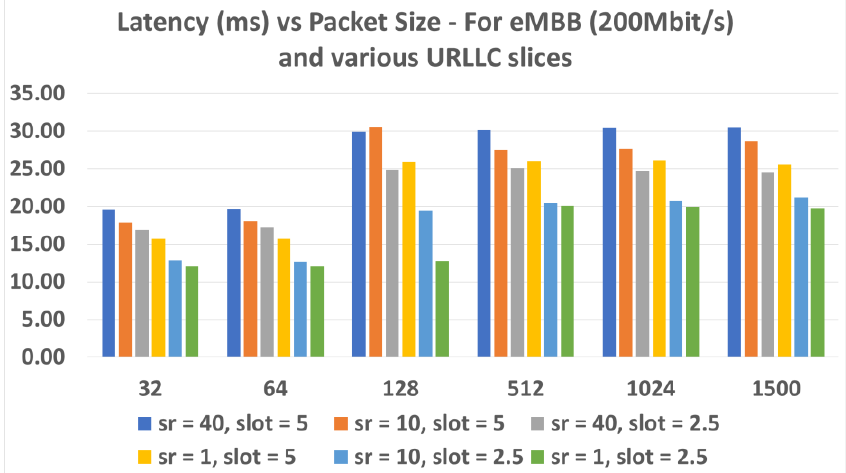
Figure 6. Latency results for a 200 (Mbits/s) eMBB slice and 6 different URLCC slices. It is evident from both set of results that the case of the URLLC slice of srPeriod = 1 and slot Period = 2.5 display the best performance in terms of latency for a URLCC slice, with an average minimum latency of ~12 ms. These values indicated the best achievable latency performance measured in the proposed 5G platform for end-to-end measure- ments. The last set of experiments was performed over the different combinatory EMBB and URLLC slices, in order to comprehensively investigate the effect of different packet sizes on different data paths and analyze their energy impact. As can be deduced, the main factor contributing to higher energy consumption is diminutive packet size, which is ex- pected, as this contrivance performs significantly more transmissions to obtain the same level of bitrate, to procure the slice bitrate requisite. Furthermore, the most consequential conclusion of these experiments is that a lower latency requires more energy, as can be clearly seen from Figure 7. The configuration for minimum latency (sr = 1, slot = 2.5) con- sumes more energy in all different packet-size cases. Consequently, the trade-off between energy consumption and latency subsists in the 5G domain. Moreover, it should be noted that 5G low-latency communications are energy efficient, as minimal additional energy